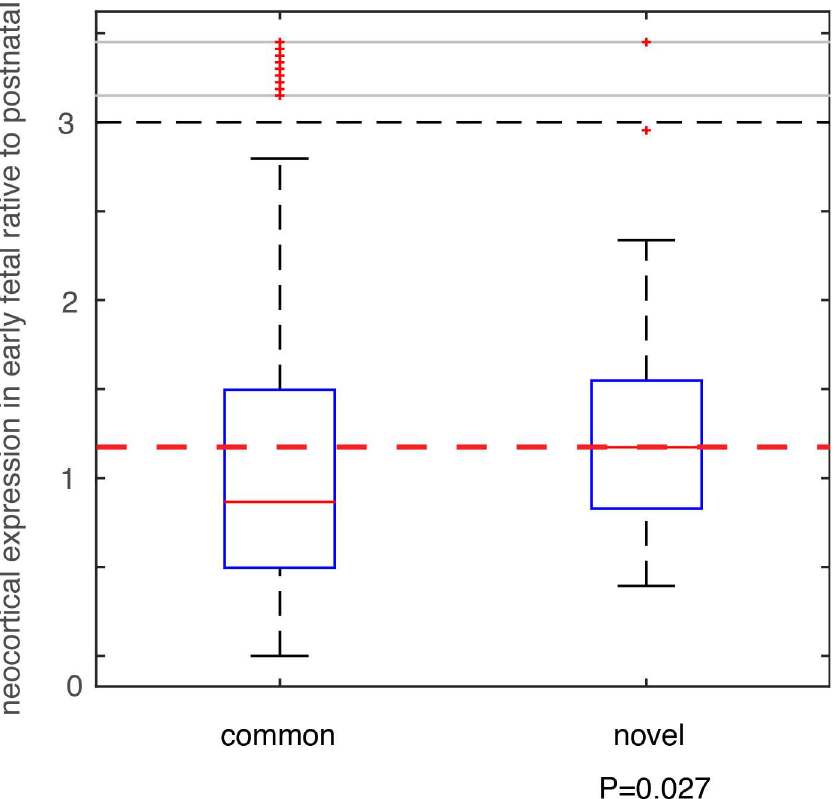
Fig 5. Testing on an independent PTB cohort. CNVs were identifiedin an independent PTB cohort, which were group into two classes based on their status as novel in PTB or as common in humanpopulation.Genes affected by these CNVs were identified,and their expression( β ) in early fetal brain development stages (PCW 8–10, 12, and 13) relative to the postnatalstages (postnatal 4, 10 and 12 months) was comparedbetweenthe two CNVs groups. Wilcoxon rank-sum test was used to determine statistical